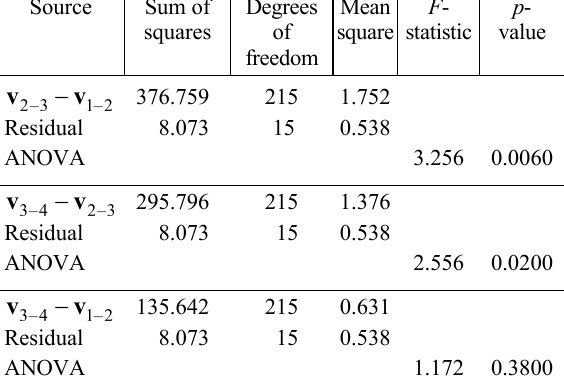
Table 3. The results of the ANOVA testing the hypothesis that differences of the vertical velocities (VVs) from Eq. (9) were zero, i.e., the VVs of the BMs were constant in time. The results are given only for the mainland part of the common levelling network Source Sum of Degrees Mean F - p - squares of square statistic freedom